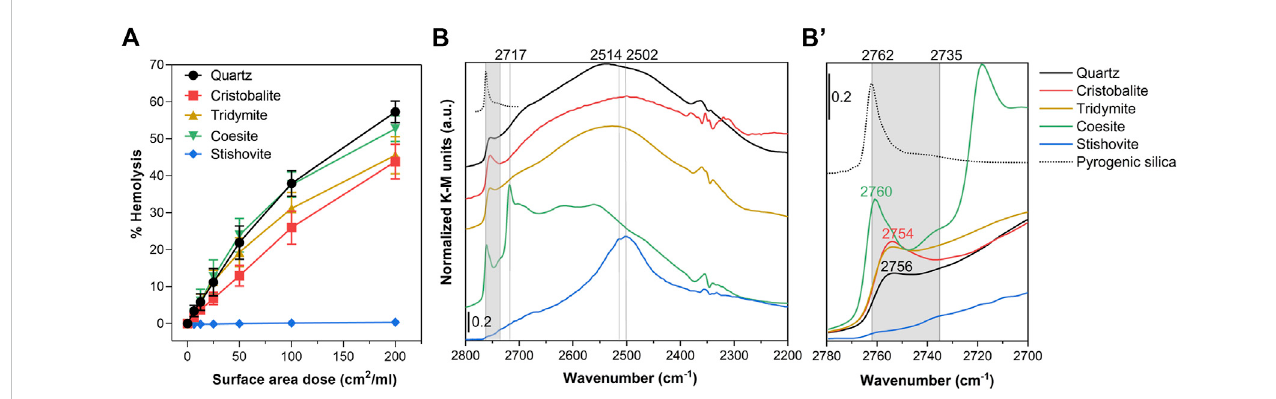
FIGURE 2 Nearlyfreesilanols(NFS) occuron somecrystalline silicapolymorphsand arerelated totheirmembranolytic activity. (A) Membranolytic activity(percent hemolysis) of CS polymorph particles. Increasing surface area doses (0, 6.25, 12.5, 25, 50, 100, and 200 cm 2 /mL) of quartz (positive reference particle), cristobalite, tridymite, coesite, and stishovite were incubated for 30 min with puri fi ed sheep RBCs. Values re fl ect the fraction of the total hemoglobin content released and are reported as mean ± SEM of three independent experiments. (B) Surface silanol distribution measured by DRIFT spectroscopy after H/D exchangeinthe ν ODspectralregion. (B ’ ) Enlargedsectionofthespectrashowingthe ν ODspectralregionassignedtoNFS(grayhighlight,2,760to2,735 cm − 1 ) and the isolated silanol peak of a pyrogenic amorphous silica (Rimola et al., 2018) reported as reference (dotted spectrum, peak at 2,762 cm − 1